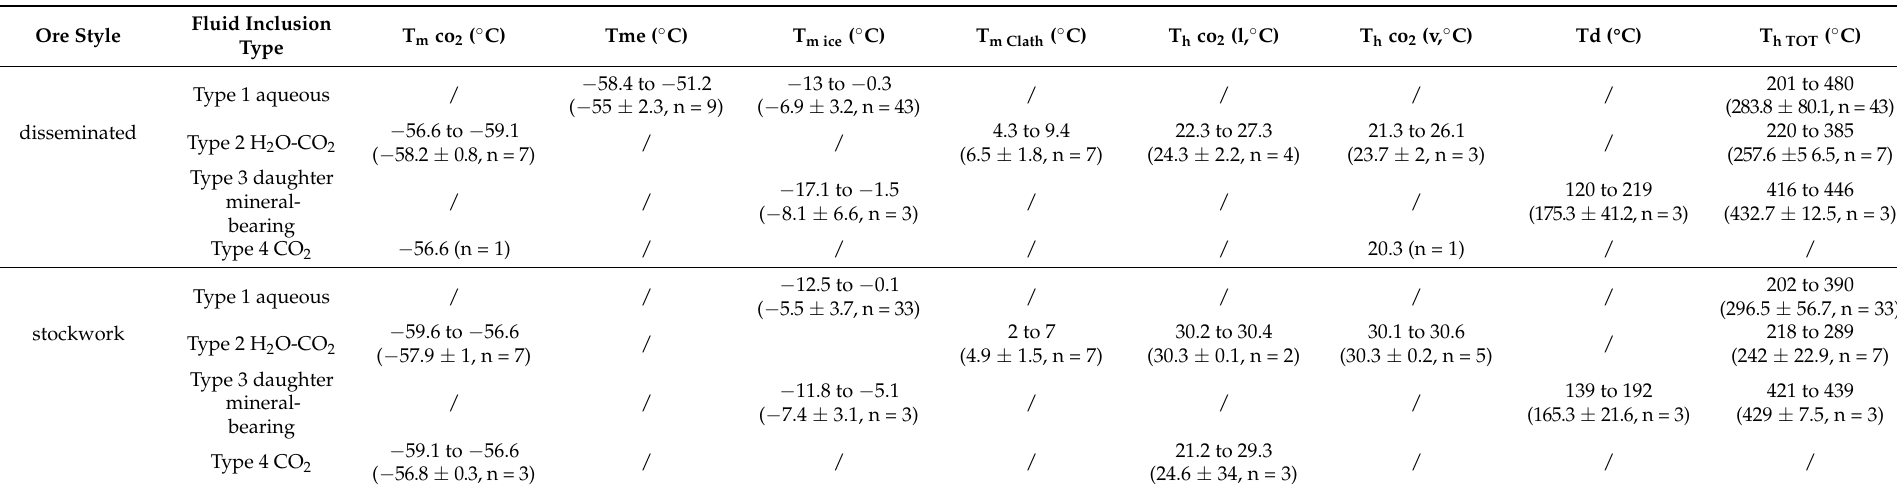
Table 1. Summary of the microthermometric data for fluid inclusions trapped in quartz at the Xiawolong gold deposit. Note: data are given as mean, 1 σ standard deviation, range, and number of